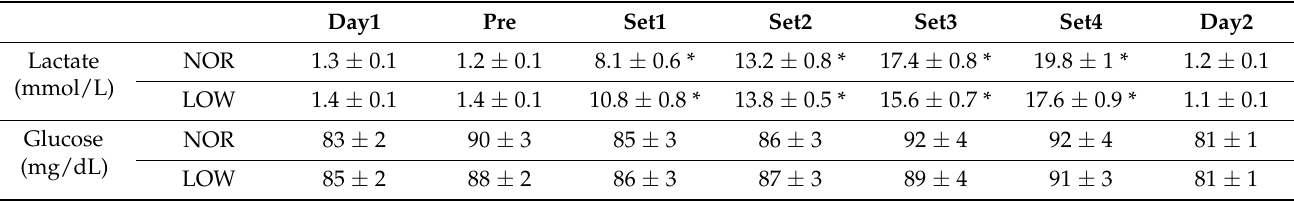
Table 2. Blood lactate and glucose